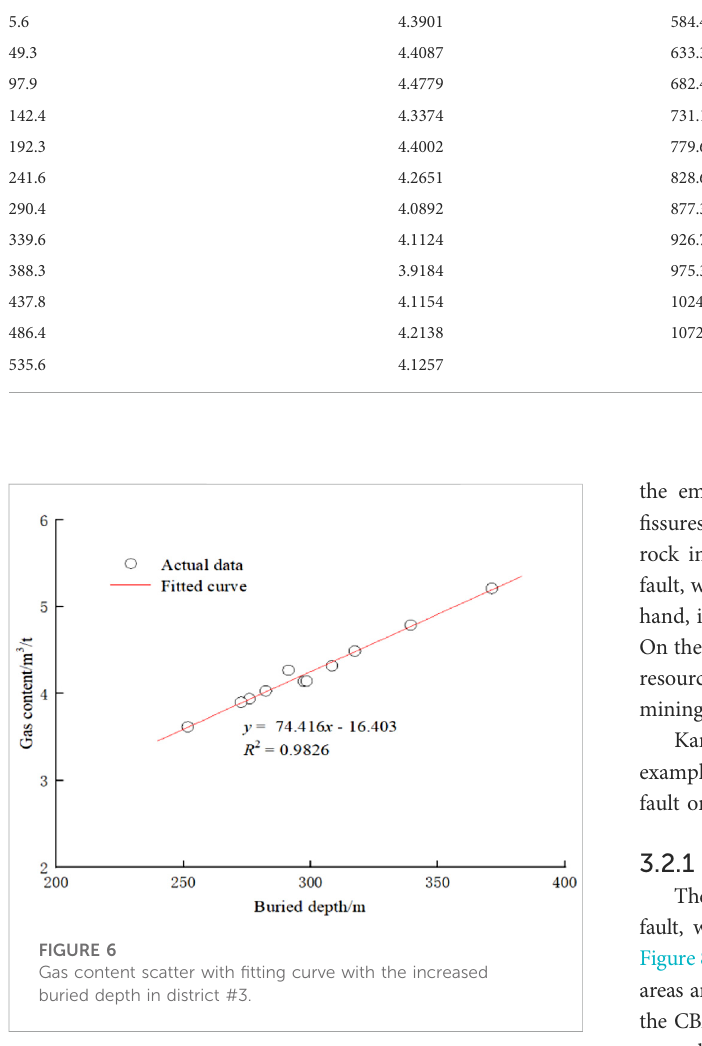
(Figure 6). The fi tting results are good, and the correlation coef fi cient reaches 0.9826. This further shows that the average value of CBM content is highly linear with the buried depth.